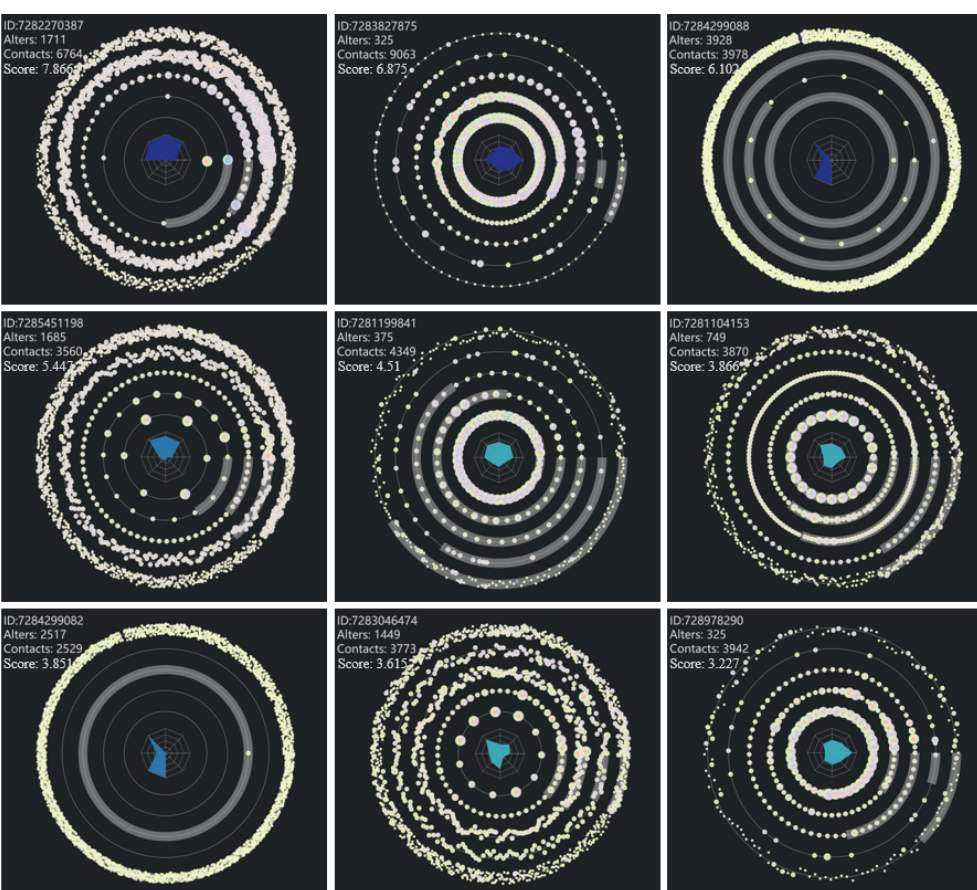
Figure 8. Top nine users’ ego views. Decrease from left to right and from top to bottom.